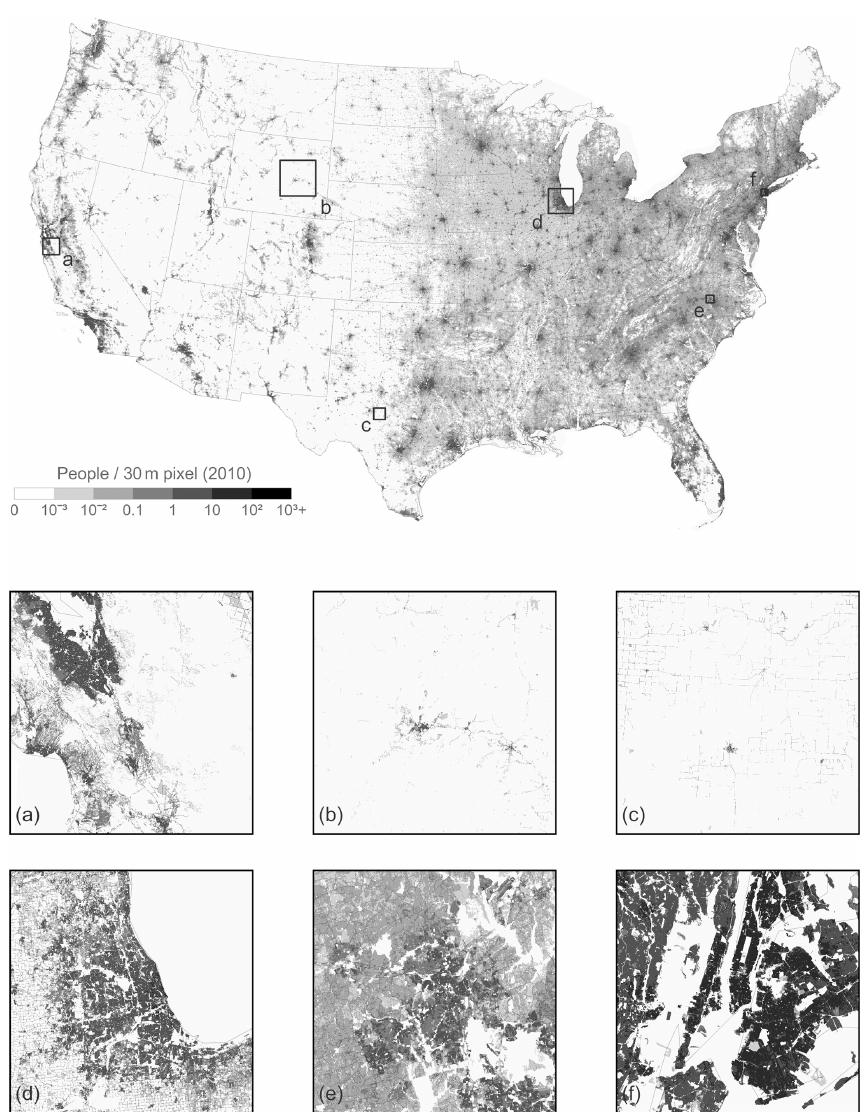
Figure 2. Population density estimated by intelligent dasymetric mapping at 30m spatial resolution for the conterminous United States and areas around (a) Santa Clara County, CA; (b) Natrona and Converse counties, WY; (c) Concho County, TX; (d) metropolitan Chicago, IL; (e) Durham County, NC; and (f) metropolitan New York City,